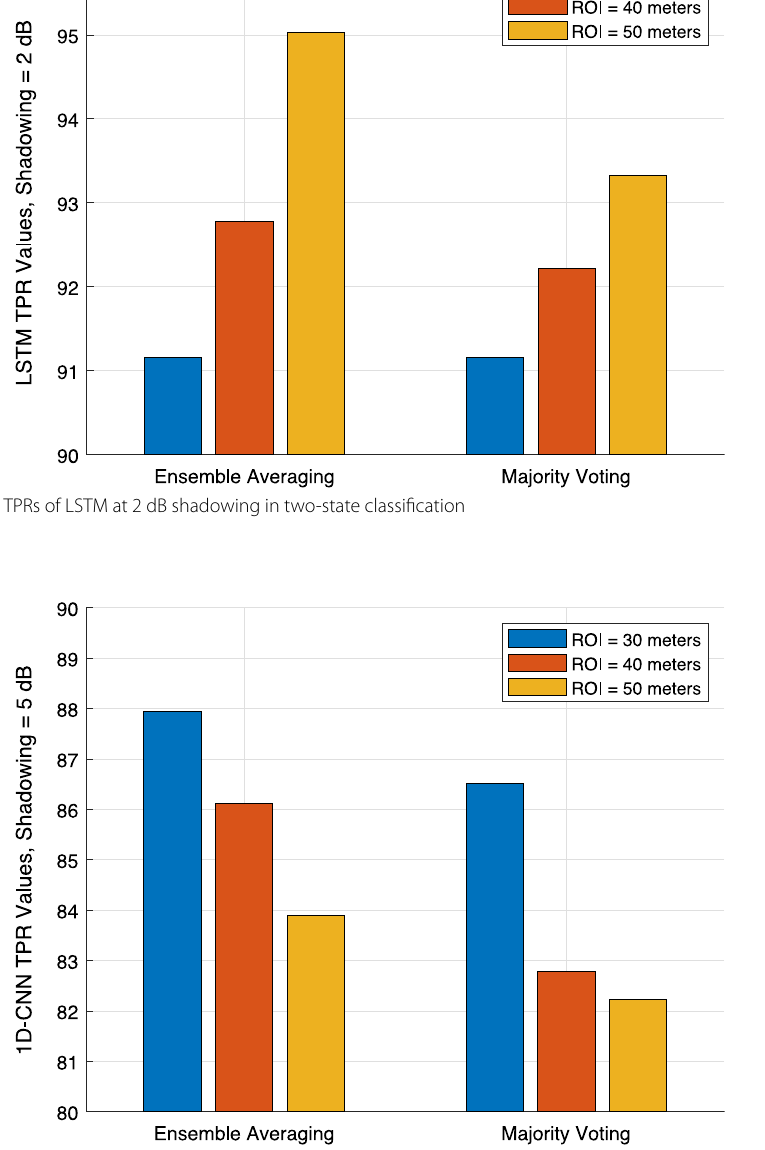
Fig. 11 TPRs of 1D CNN at 5 dB shadowing in two-state